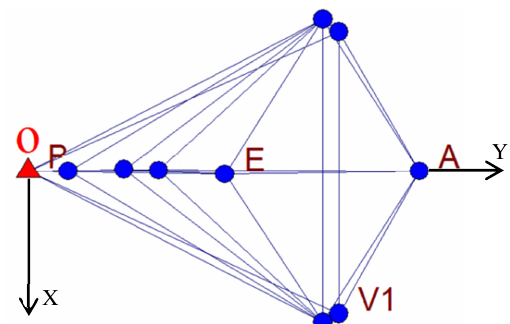
Figure 2. Schema of the positions of the various instruments on the cross